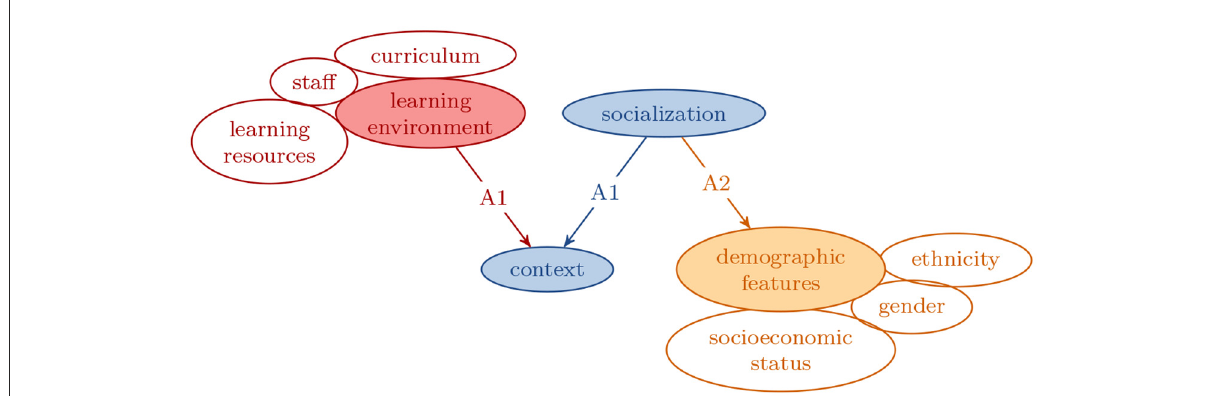
FIGURE2 A closer look at the place (or environment) plate. It highlights a (few) external factors that influences an individuals’ knowledge and behavior. Citations: A1 (Csikszentmihalyi, 2014; Amabile, 2018), A2 (Runco et al., 2017; Castillo-Vergara et al.,